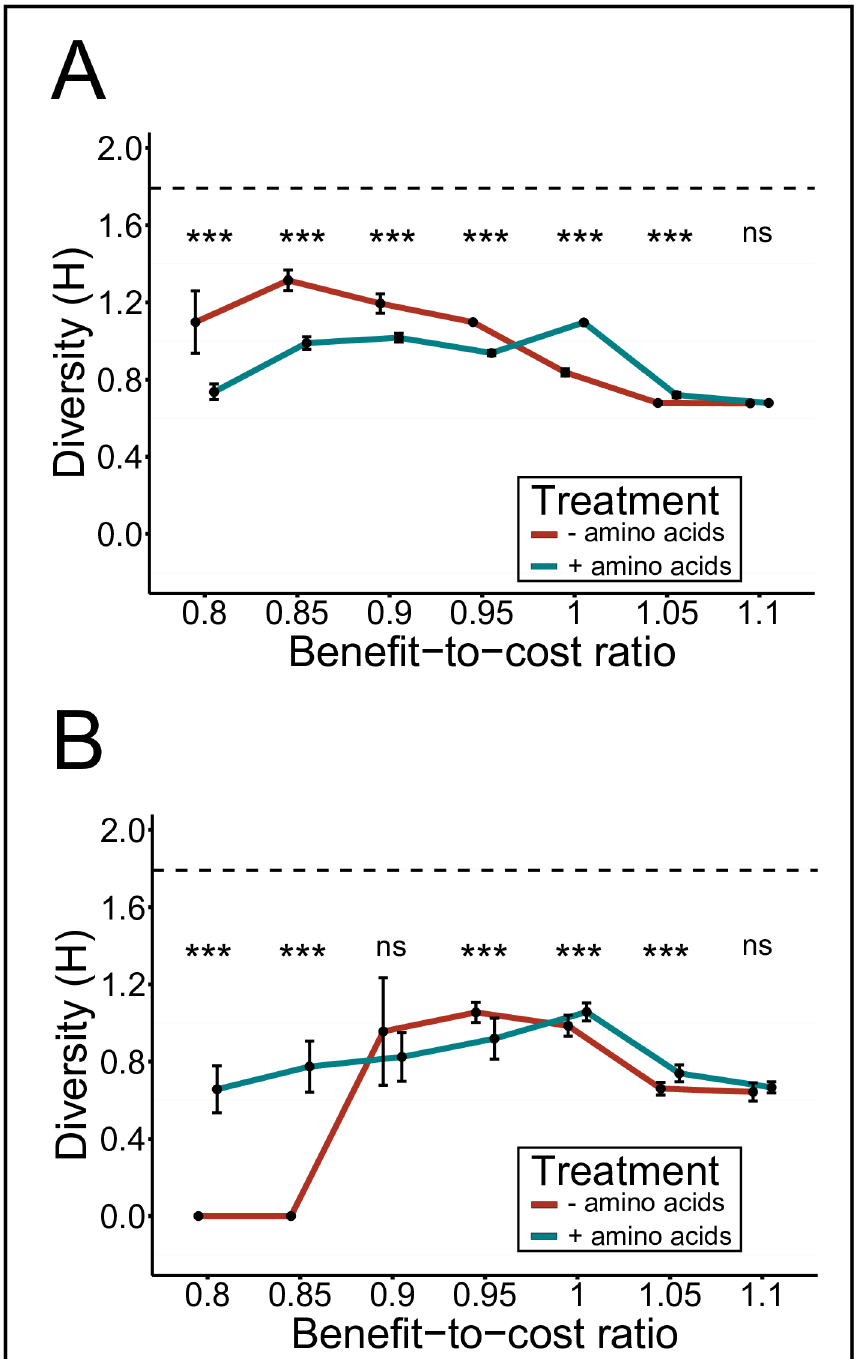
Fig 4. Metabolic cross-feeding increases genotypic diversity within bacterial populations. Mean Shannon-Weaver diversity indices (H ± standard deviation) of simulated populations with varying benefit-to- cost ratios (BCR) are shown. Simulations were performed in the presence (blue line) or absence (red line) of environmentally supplemented amino acids in ( A ) spatially structured (i.e. low diffusion) and ( B ) unstructured environments (i.e. high diffusion). The dashed line indicates the maximally achievable diversity index for six genotypes. Asterisks indicate significant differences between the amino acid supplemented- and unsupplemented environment for a given BCR (FDR-corrected two-sample t-test: *** P < 0.001, ns: P > 0.05, n = 50).